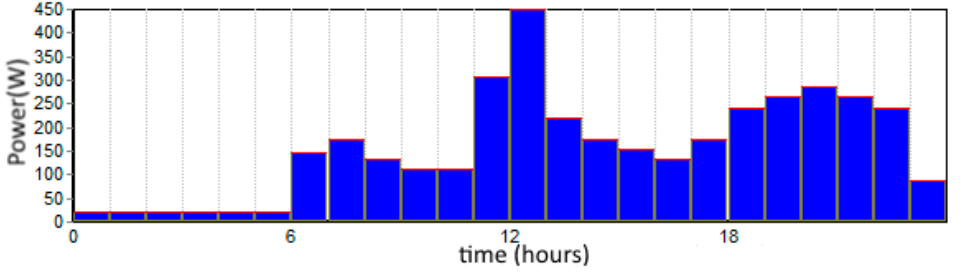
Figure 9. Daily load curve (iHOGA).